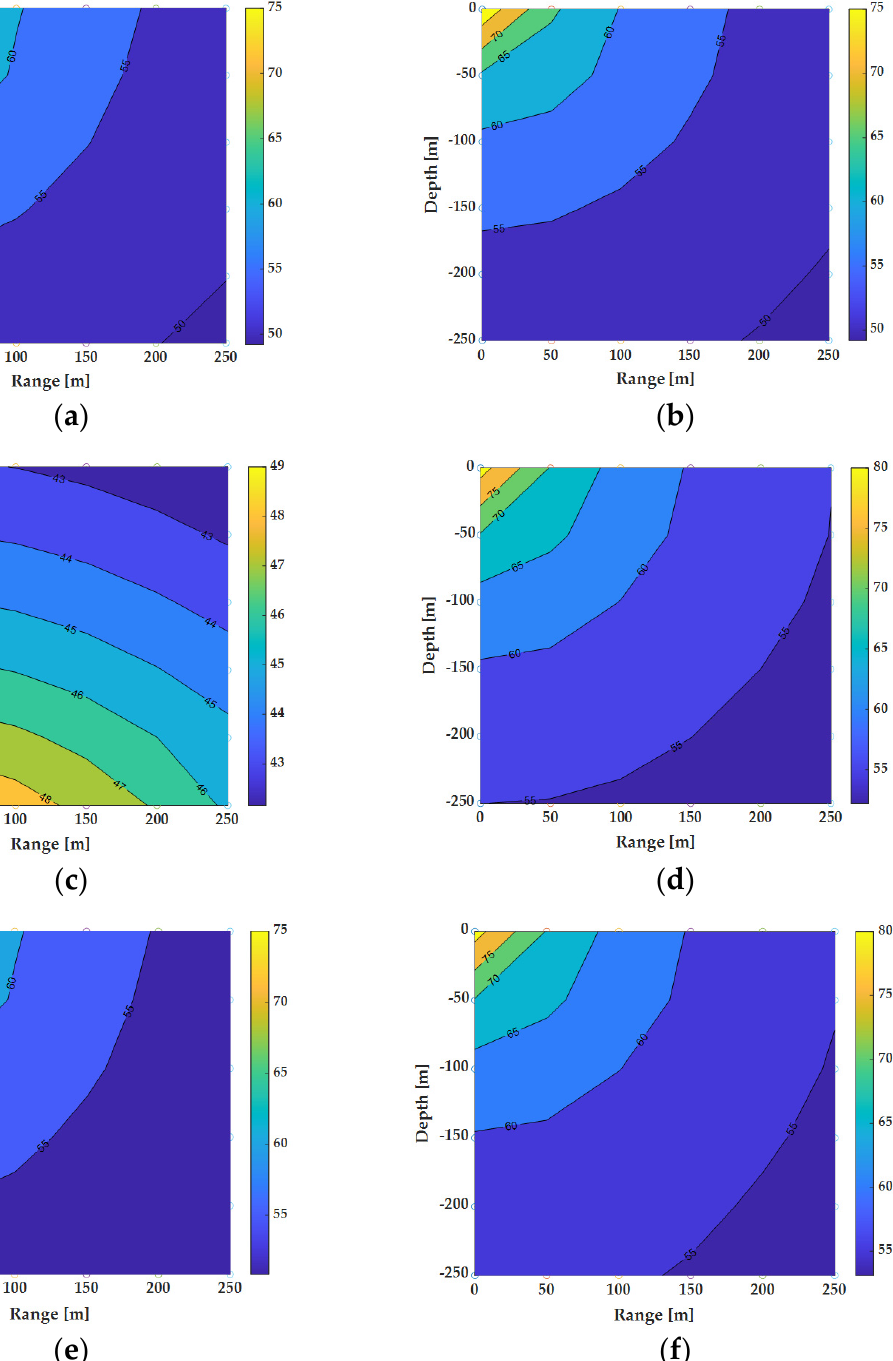
Figure 6. Acoustic field propagation at 250 m: ( a ) direct sound field; ( b ) reflection on the free side; ( c ) reflection on the sea floor; ( d ) direct and reflected field on the free side combination; ( e ) direct and reflected on the sea floor combination; ( f ) global sound field.